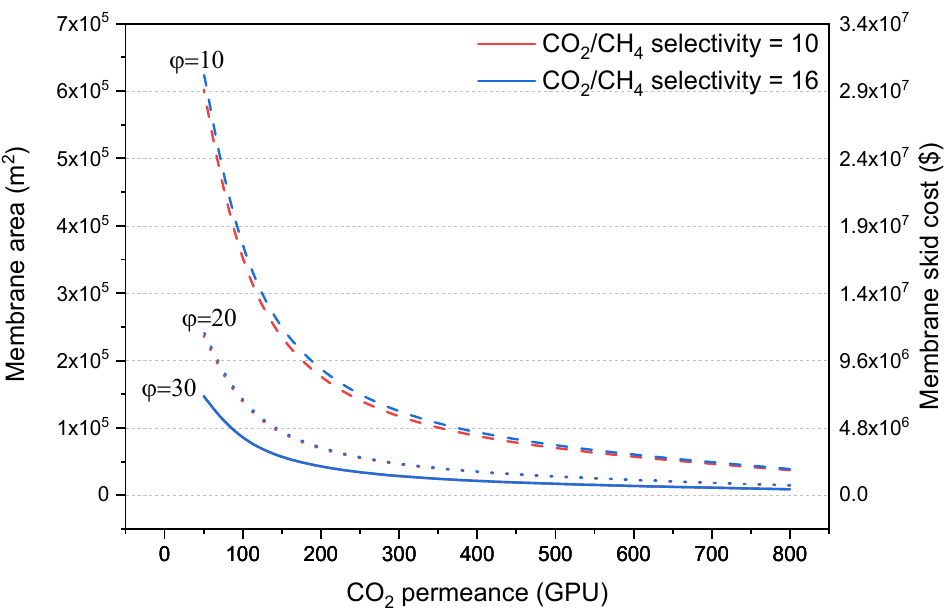
Figure 3. Effect of CO 2 permeance on membrane area (left axis) and membrane skid cost (right axis) at CO 2 / CH 4 selectivity values of 10 (red lines) and 16 (blue lines) and pressure ratio values ( ϕ ) of 10 (dash lines), 20 (dot lines) and 30 (solid lines).